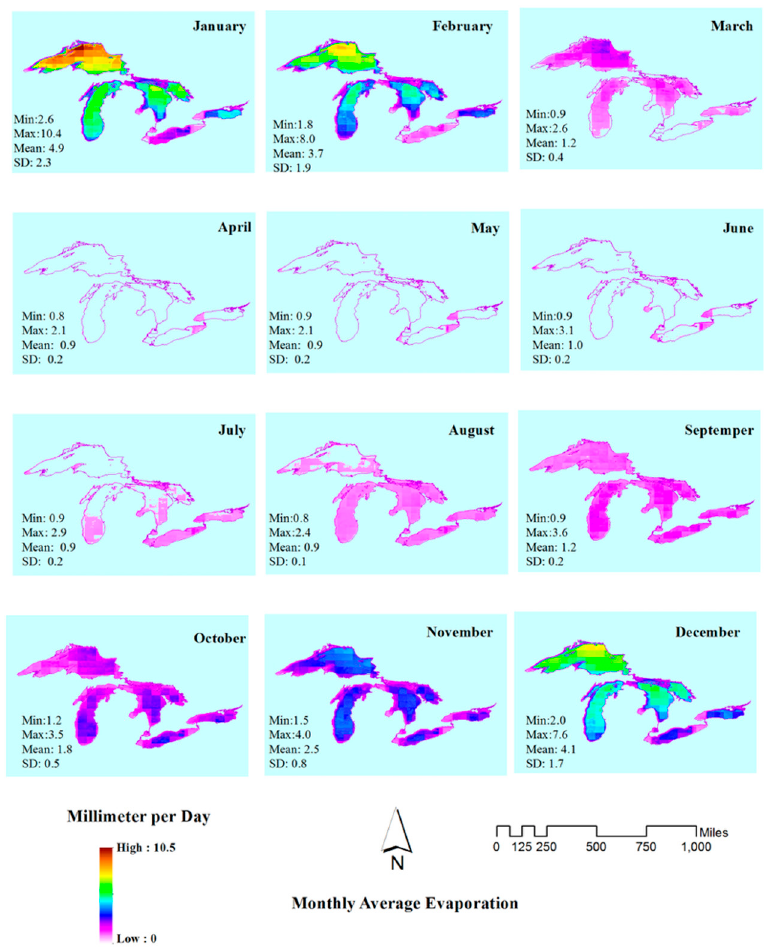
Figure 5. Spatial variation of the Great Lakes monthly average evaporation (mm) from July 2001 to December 2014.